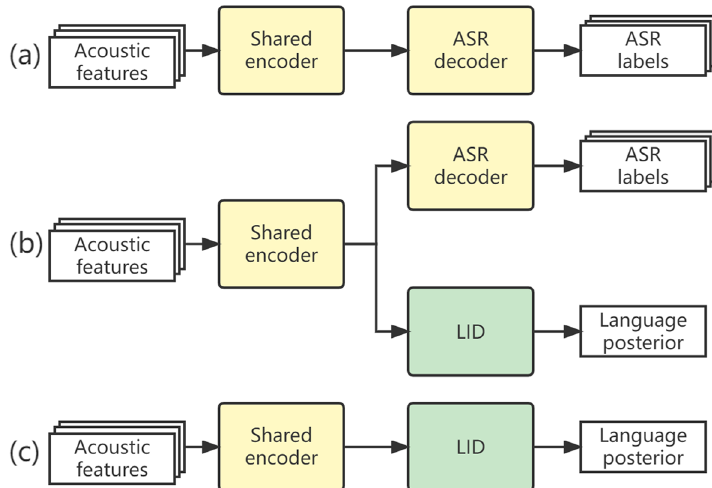
Fig. 4 The proposed three-stage training strategy. a The first end-to-end ASR training stage. b The second multi-task training stage. c The final end-to-end LID training